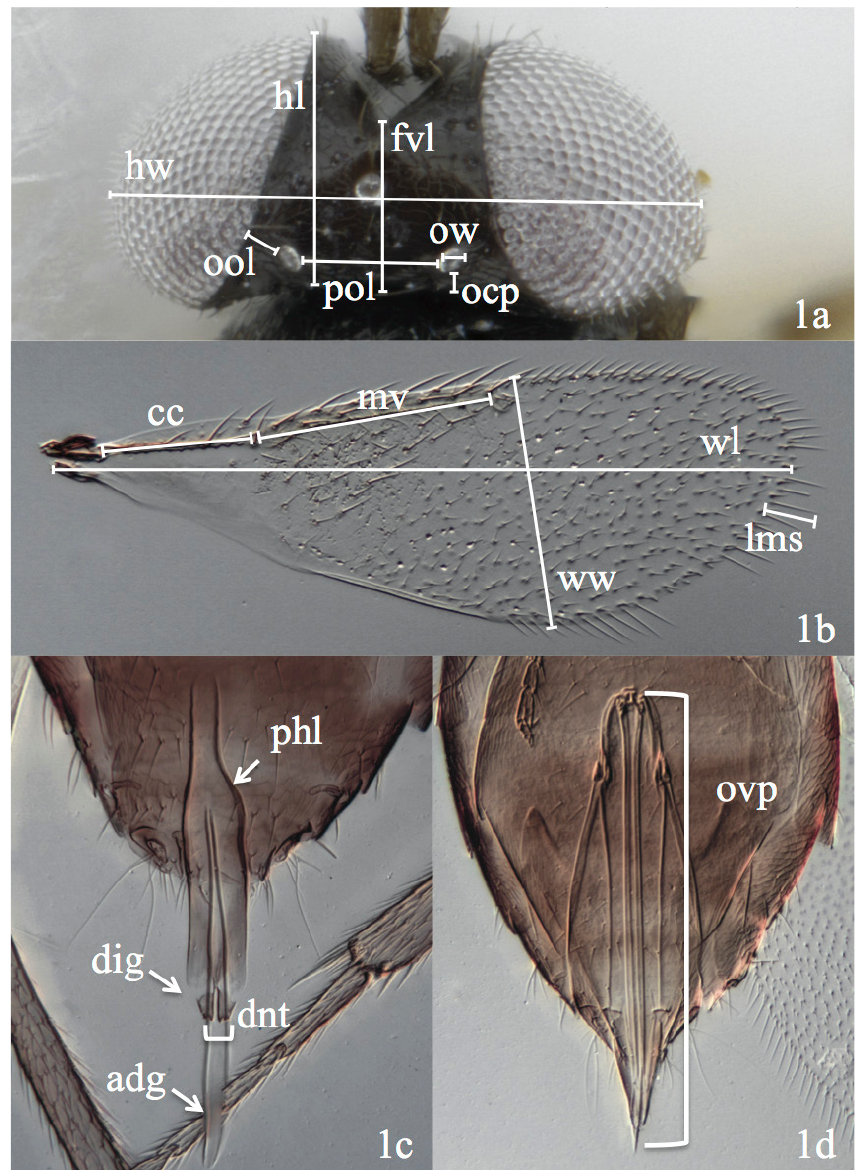
Figure 1. Measurements and terminology. 1a Aphelinus kazakhstanensis sp. n. female, head, dorsal view (TAMU-ENTO X0856040) (fvl: frontovertex length; hl: head length; hw: head width; ocp: posterior ocellus to occipital margin distance; ool: posterior ocellus to eye margin distance; ow: posterior ocellus width; pol: posterior interocellar distance) 1b Aphelinus sinensis sp. n. female, fore wing, dorsal view (TAMU-ENTO X0852875) (cc: costal cell length; lms: longest marginal seta length; mv: marginal vein length; wl: wing length; ww: wing width) 1c Aphelinus certus male genitalia, ventral view (TAMU-ENTO X0616479) (adg = aedeagus; dig = digiti; dnt = denticles; phl = phallobase) 1d Aphelinus atriplicis female, metasoma, ventral view (TAMU-ENTO X0616471) (ovp =